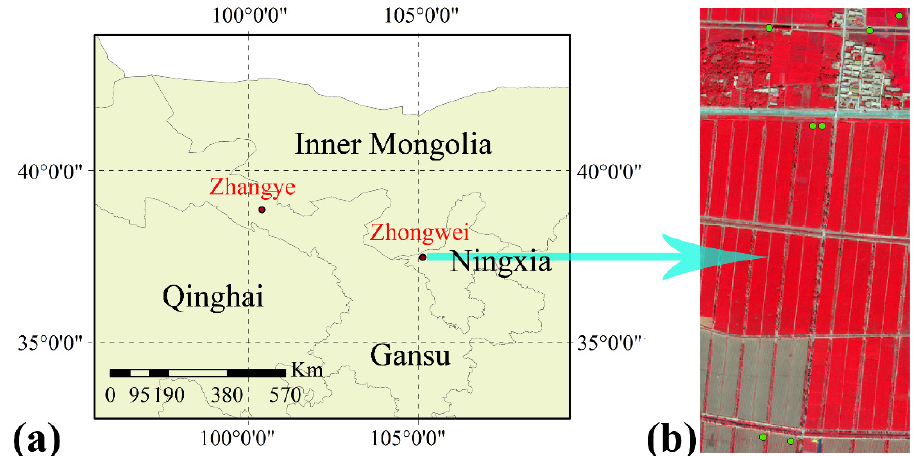
Figure 5. Geographic location of the study area ( a ) Plots in Zhangye and Zhongwe; ( b ) World-View 3 image in the Zhongwei area and its corresponding quadrats. Here, the field measurement was performed in Zhangye, hence there is no satellite image. The green points in ( b ) represent the quadrats in the field measurement with the same size as the resolution of the World-View 3